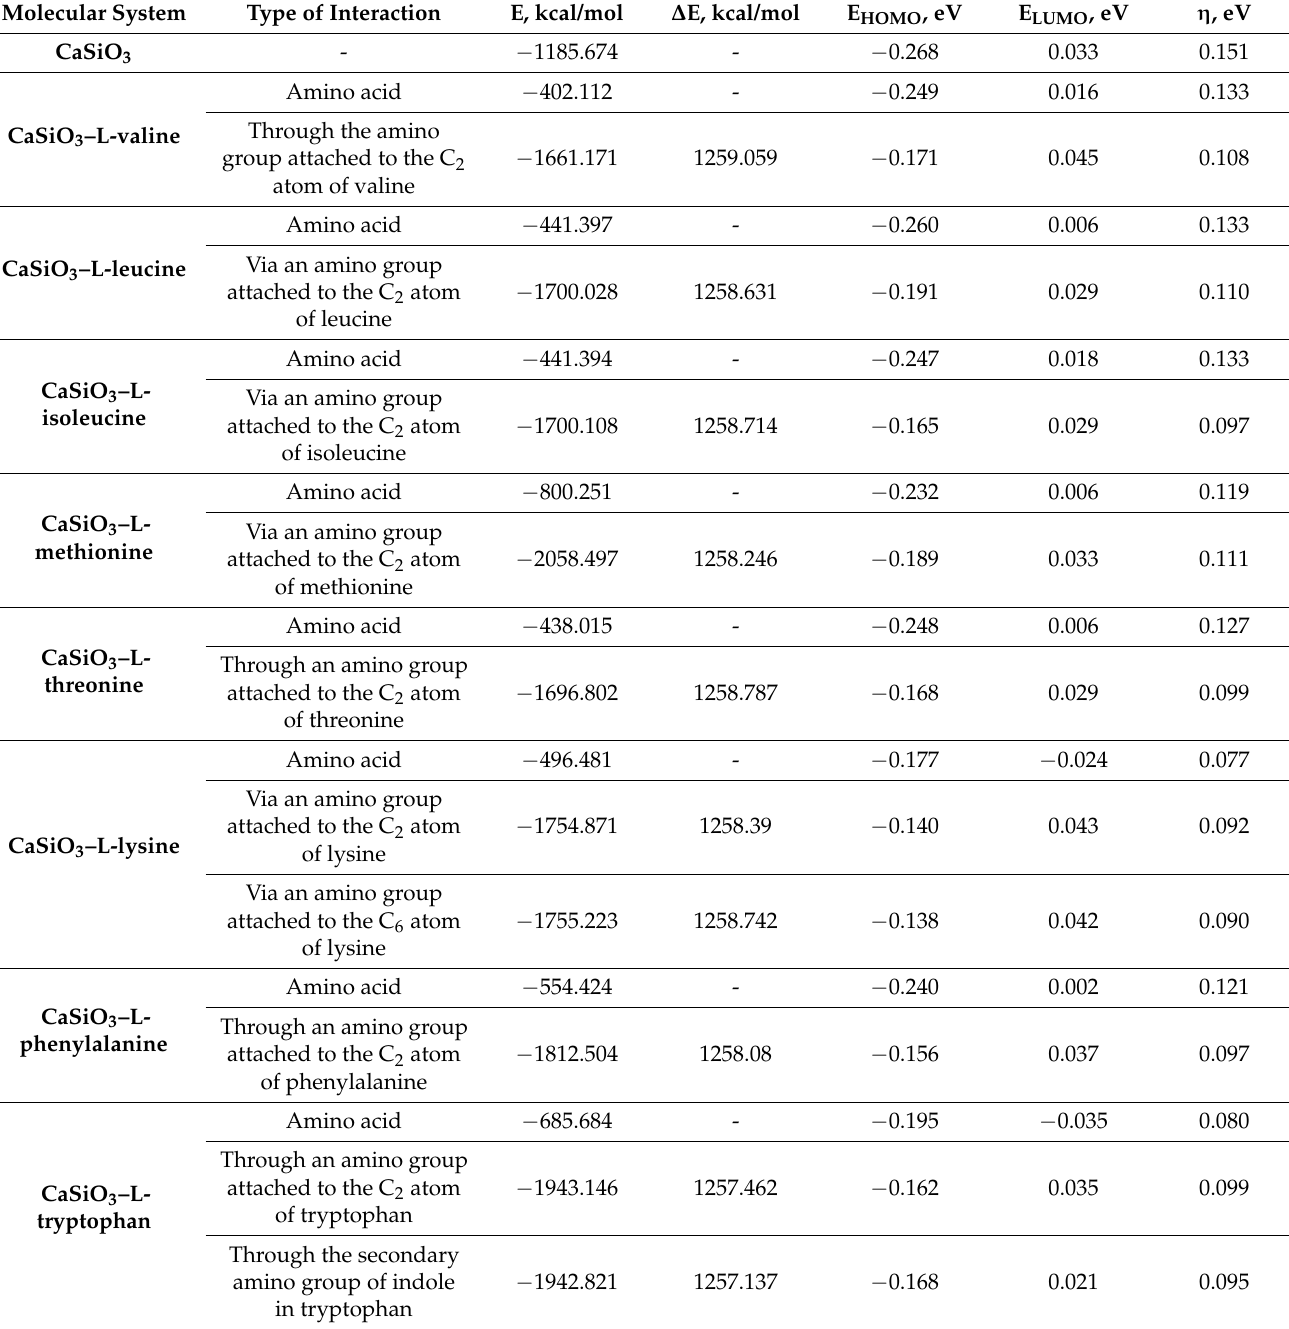
Table 1. Modeling results of calcium silicate with amino